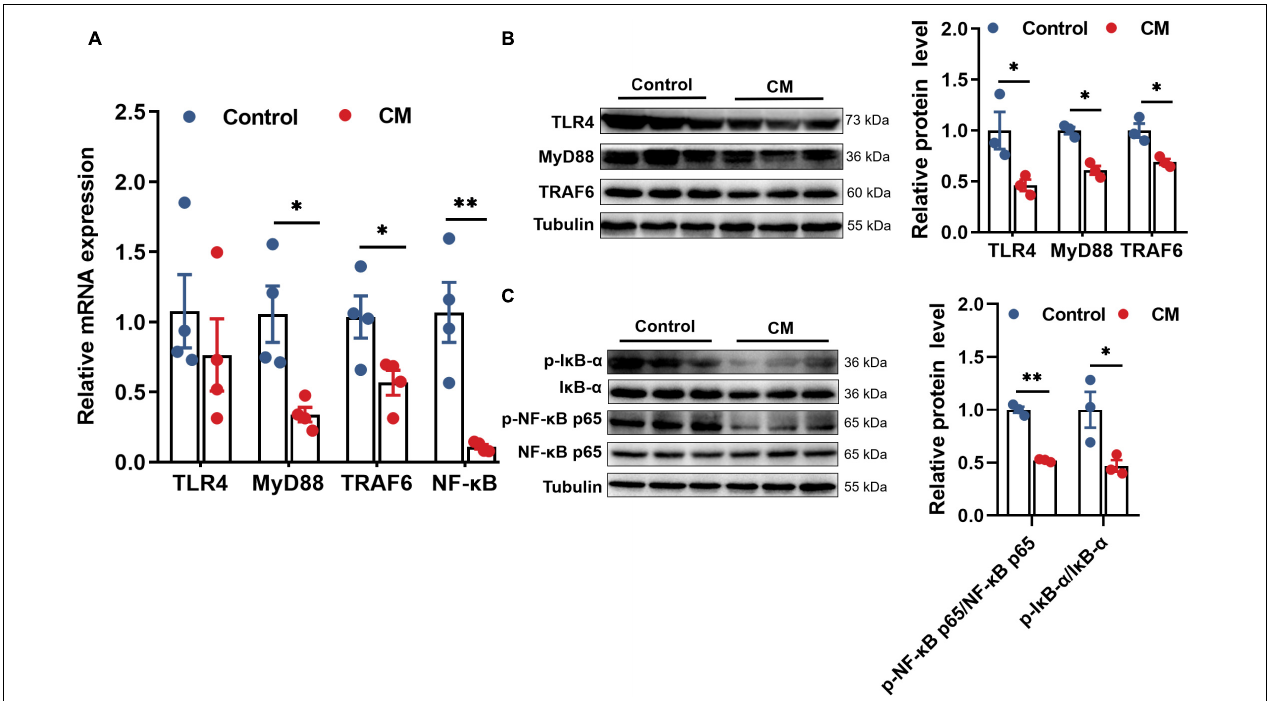
FIGURE 4 | CM inhibits the TLR4/MyD88/NF- κ B signaling pathway. (A) RT-qPCR analysis of the mRNA expression levels of TLR4, MyD88, TRAF6, and NF- κ B ( n = 4). (B) Western blot analysis of the protein expression levels of TLR4, MyD88, and TRAF6 ( n = 3). (C) Western blot analysis of the protein expression levels of p-NF- κ B p65 and p-I κ B- α ( n = 3). Control, pigs fed a basal diet; CM, pigs fed the basal diet supplemented with CM at 300 mg/kg. Data are presented as the mean ± SEM. ∗ P < 0.05, ∗∗ P <